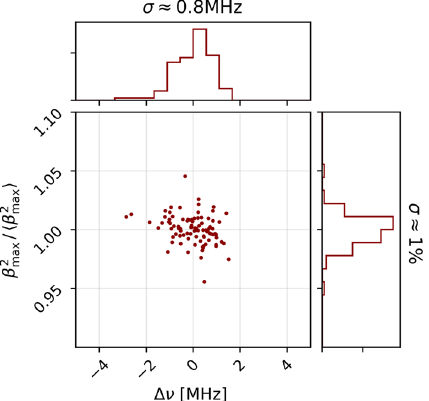
Fig. 11 Scatter plot of the obtained power boost factor frequency posi- tionsandamplitudesafterfittingthemodeltothemeasuredgroupdelays corresponding to the physical disk positions shown in Fig. 9. The hor- izontal axis shows the frequency shift of the boost factor maximum frequency compared to the mean of the considered ensemble. The ver- tical axis shows the relative boost factor amplitude deviation compared to the mean of the